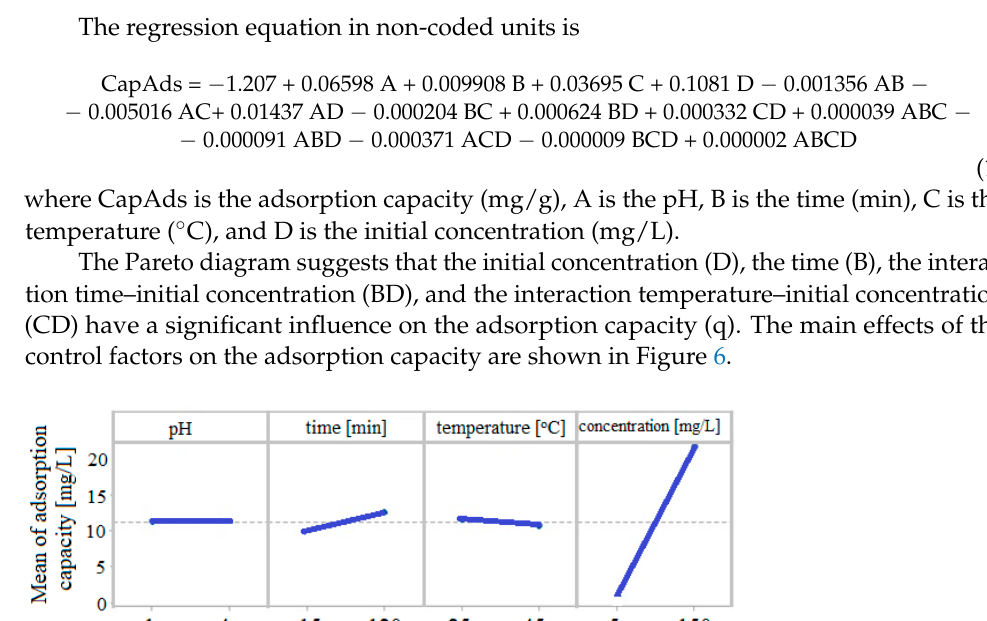
Figure 5. Pareto diagram—effect of the control parameters on adsorption capacity.